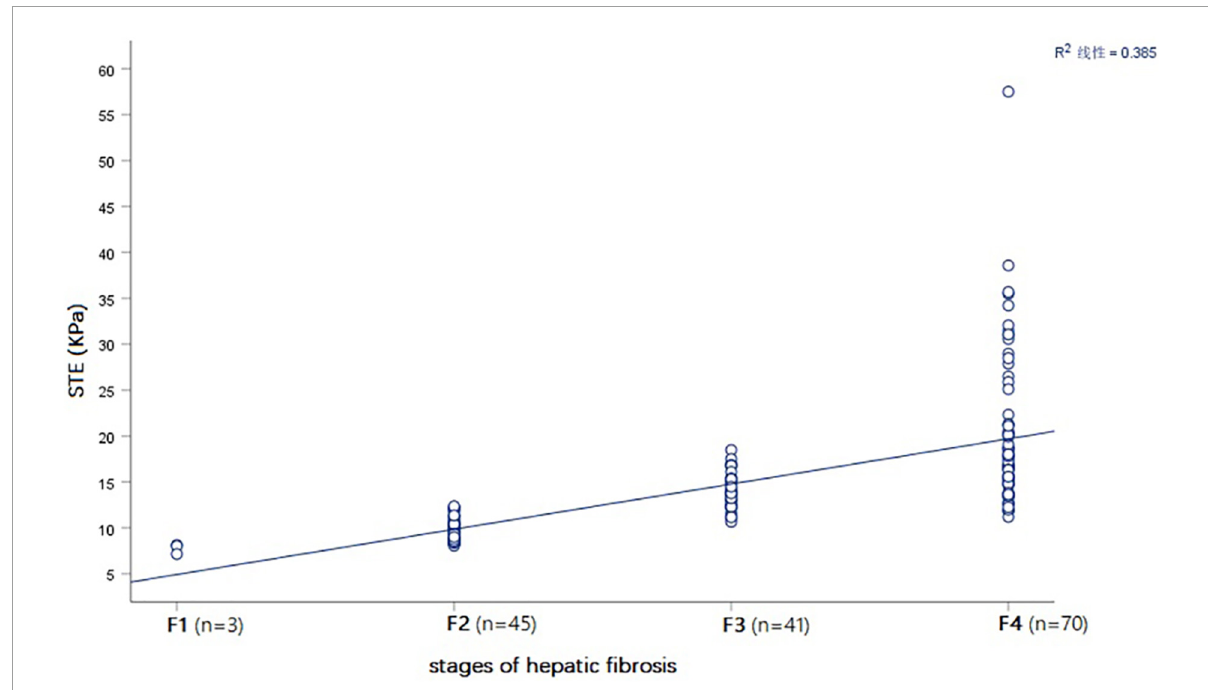
FIGURE6 Spearman correlation plot showing that that STE value (KPa) was positively correlated with the stages of hepatic fibrosis in all BA patients.